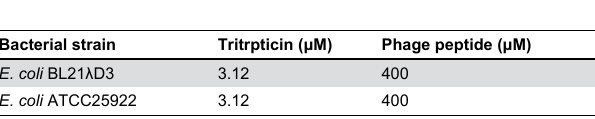
Table 2. MIC values of tritrpticin and phage peptide against different bacterial